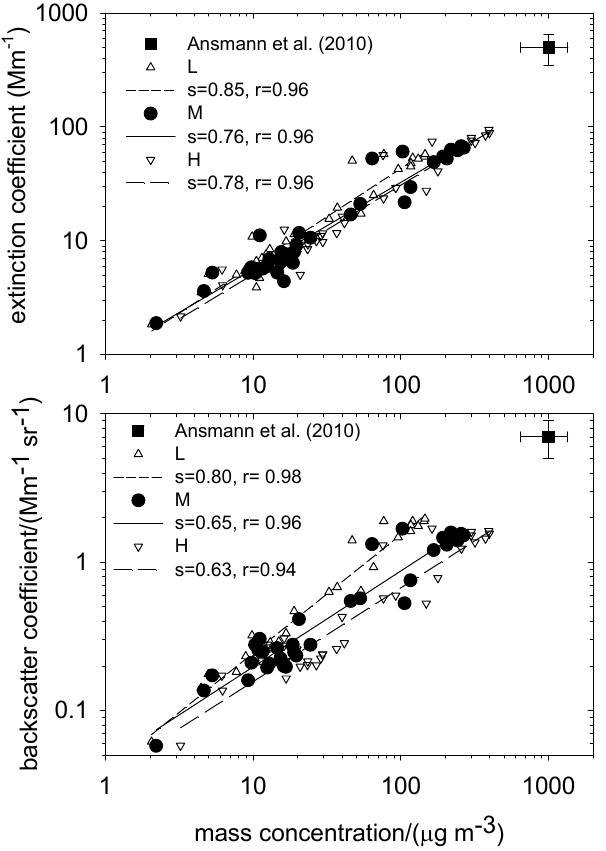
Fig. 24. Extinction coefficient α and backscatter coefficient β for 532nm wavelength versus particle mass concentration c as com- puted using T-matrix approximation for prolate spheroids (aspect ratio 1.6), including Aitken, accumulation and coarse mode parti- cles, and various refractive indices and corresponding FSSP data (cases L, M, and H, see Table 5). The slope s and correlation coeffi- cient r of a linear regression are given. Also included are the results of ground-based observations for Leipzig, 16 April 2010 (Ansmann et al.,